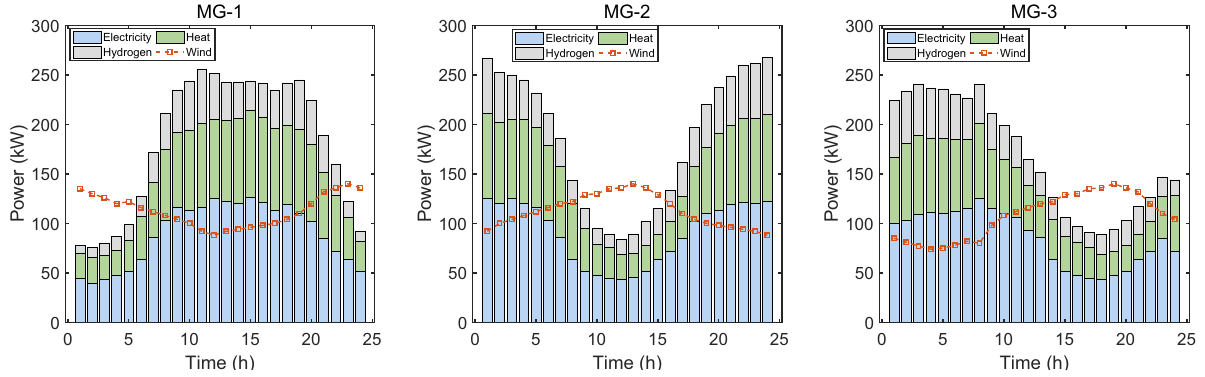
Figure 6. Load demands and wind power generation of